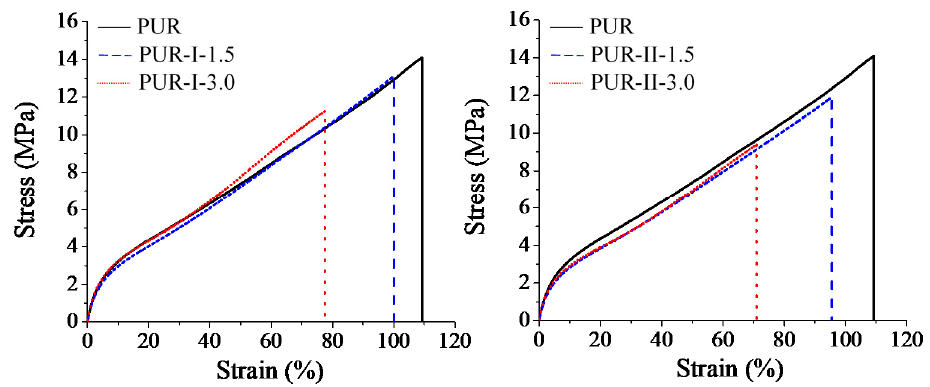
Figure 9. Stress–strain curves of various cured Figure 9 . Stress–strain curves of various cured PUR.